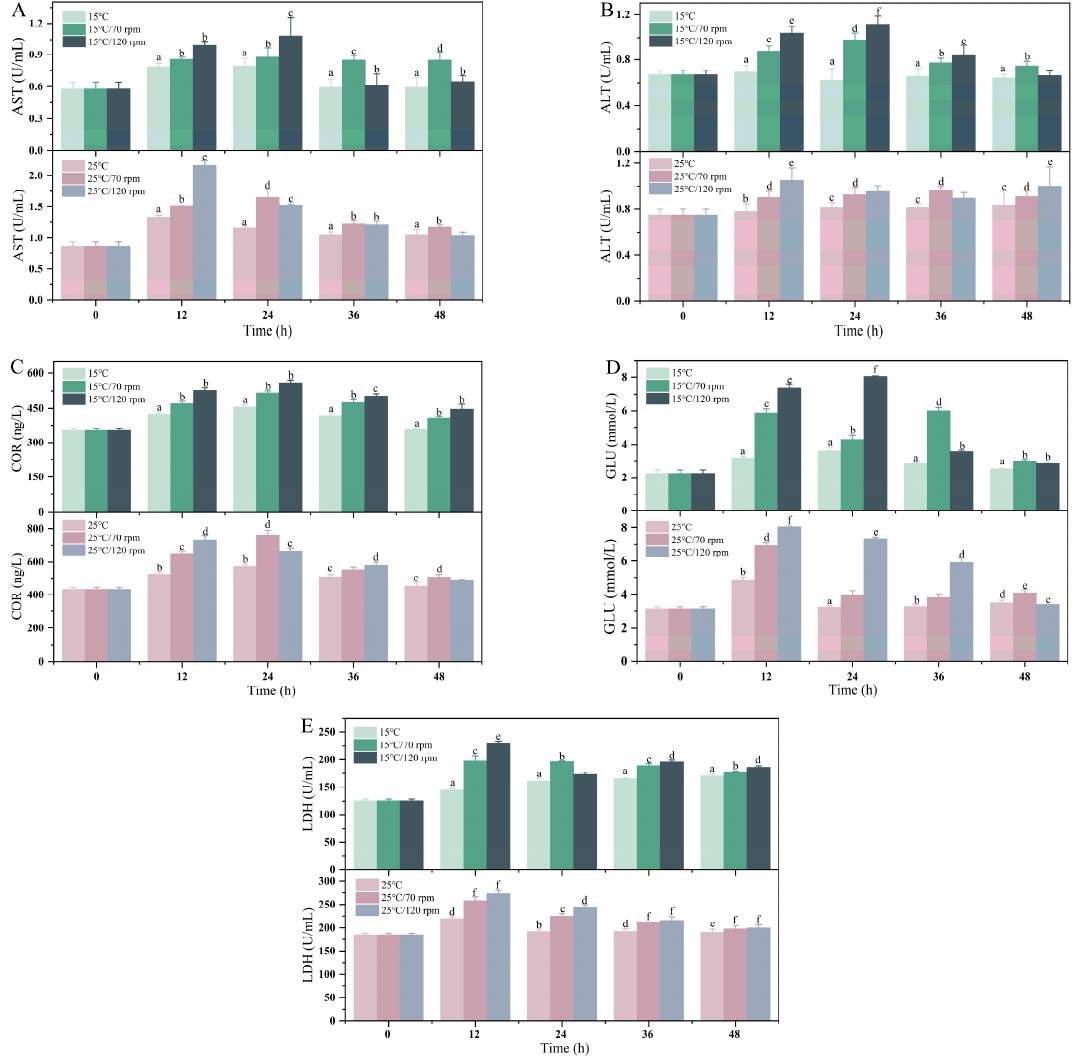
Figure 3. Changes in ( A ) serum AST, ( B ) ALT, ( C ) COR, ( D ) GLU, and ( E ) LDH during transport. Values were obtained from average of all samples and given as means ± SD (n = 5). Different letters above the bars indicate significant differences among the treatments.